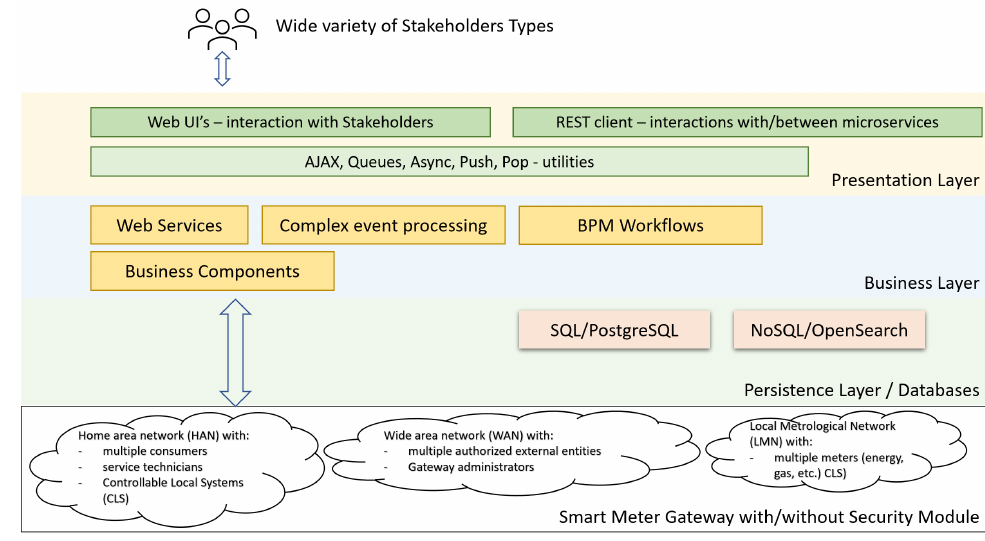
Figure 14. Smart meter architectural context.